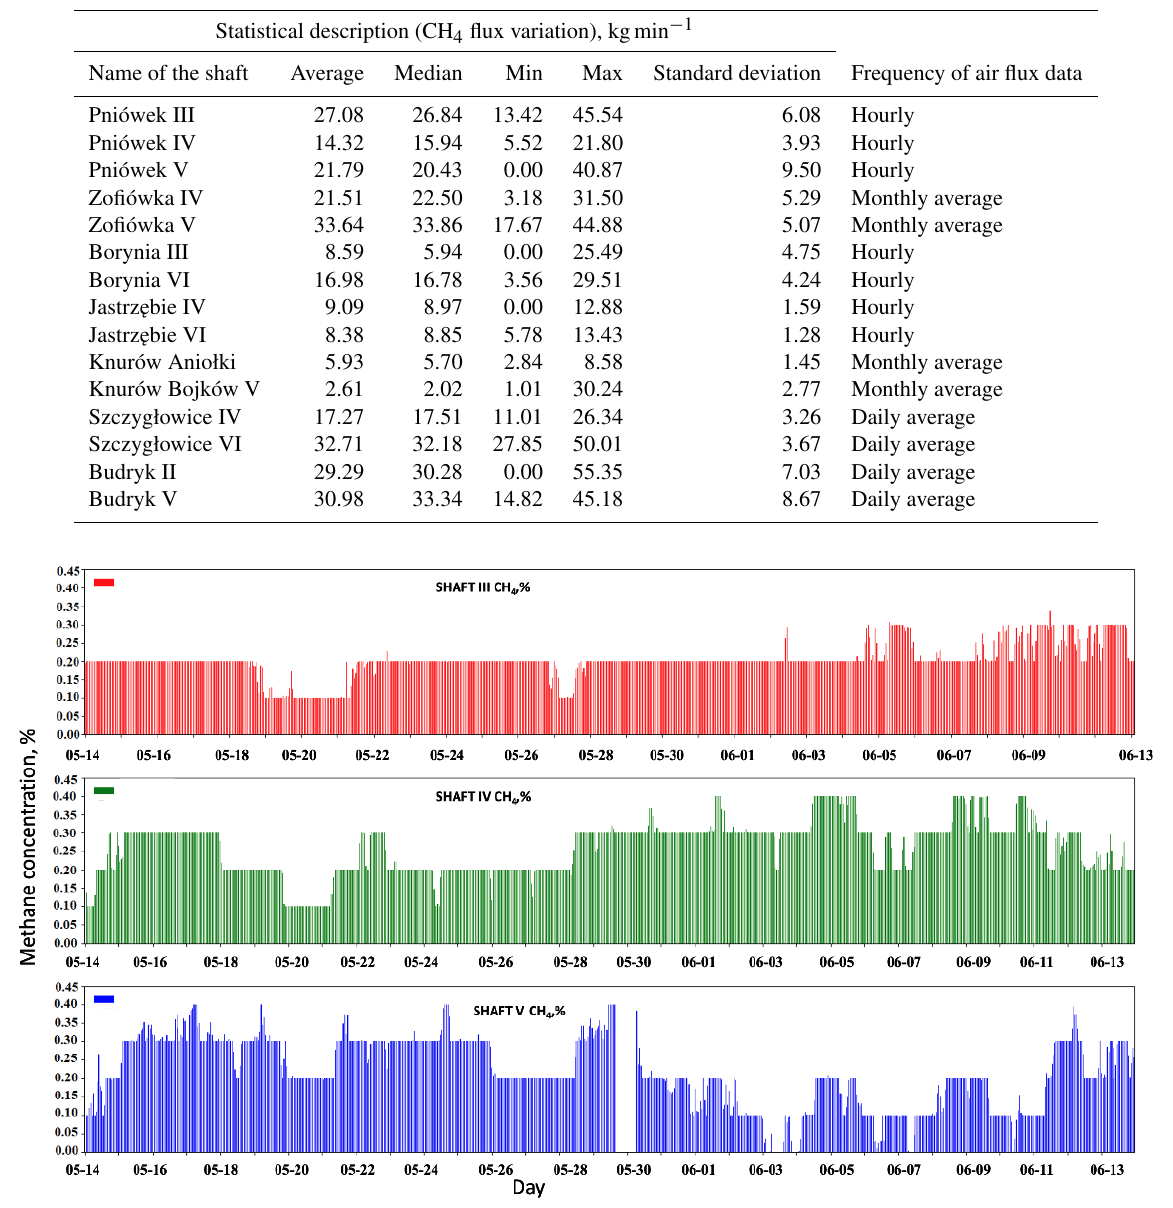
Figure 7. Variability of hourly data of methane concentration in Pniówek V and IV coal mine shafts from 14 May to 13 June